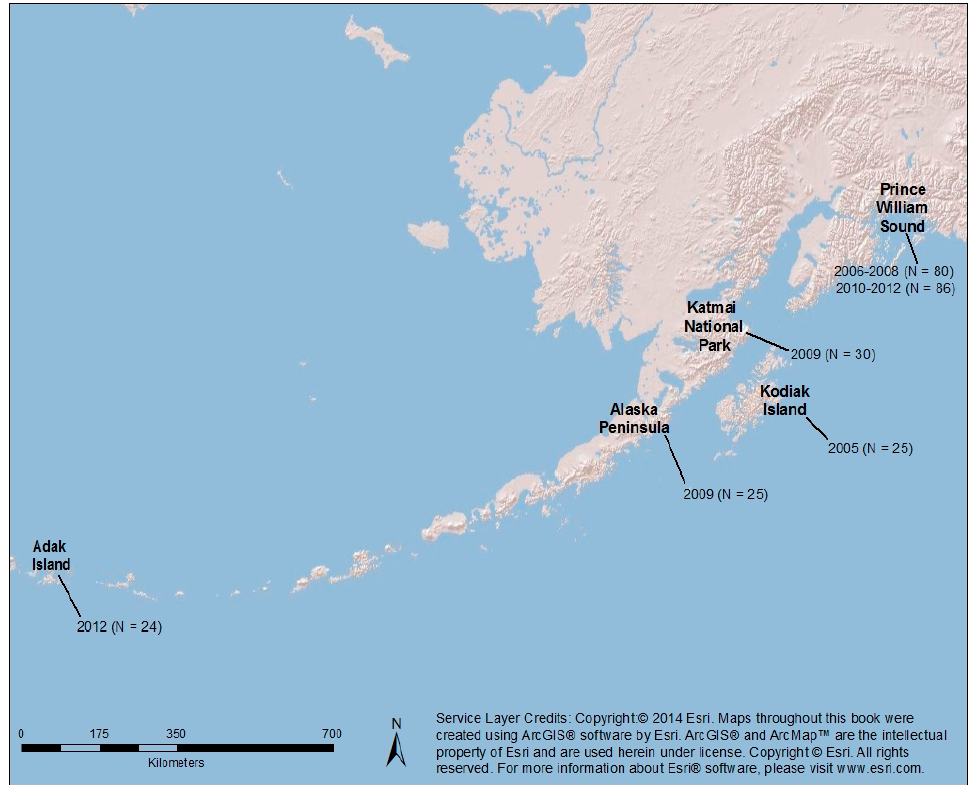
Figure 1. Map of sampling locations in Alaska, including Adak Island (Clam Lagoon, CL), the Alaska Peninsula (AP), Katmai National Park (KAT), Kodiak Island (KOD) and Prince William Sound (PWS1 and PWS2). Captive sampling locations are not shown.